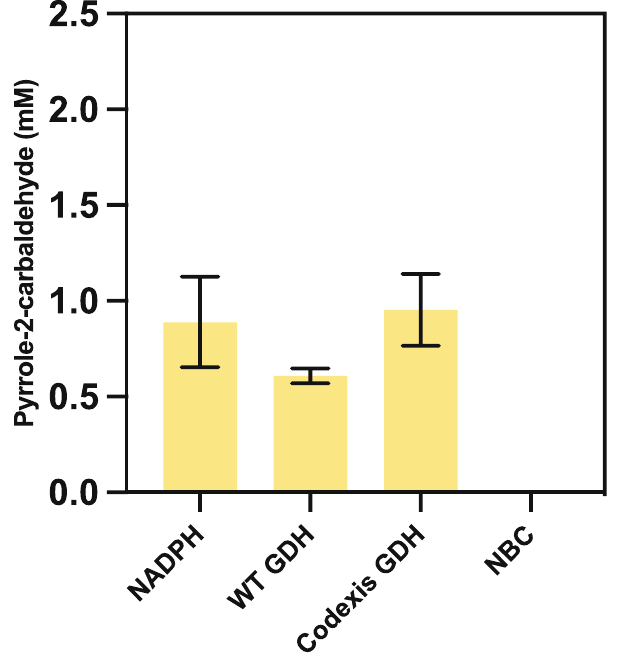
Figure 3. Comparative pyrrole-2-carbaldehyde yield, obtained from coupling purified PA0254 and CARse enzymes in the presence of 500 mM KHCO 3 , as analysed via HPLC from replacement of 20 mM NADPH with wildtype bsGDH or commercially available CODEXIS CDX901-GDH at 0.30 mg/mL in the presence of 50 mM glucose. Reactions were incubated at 30 °C for 18 h. No observable